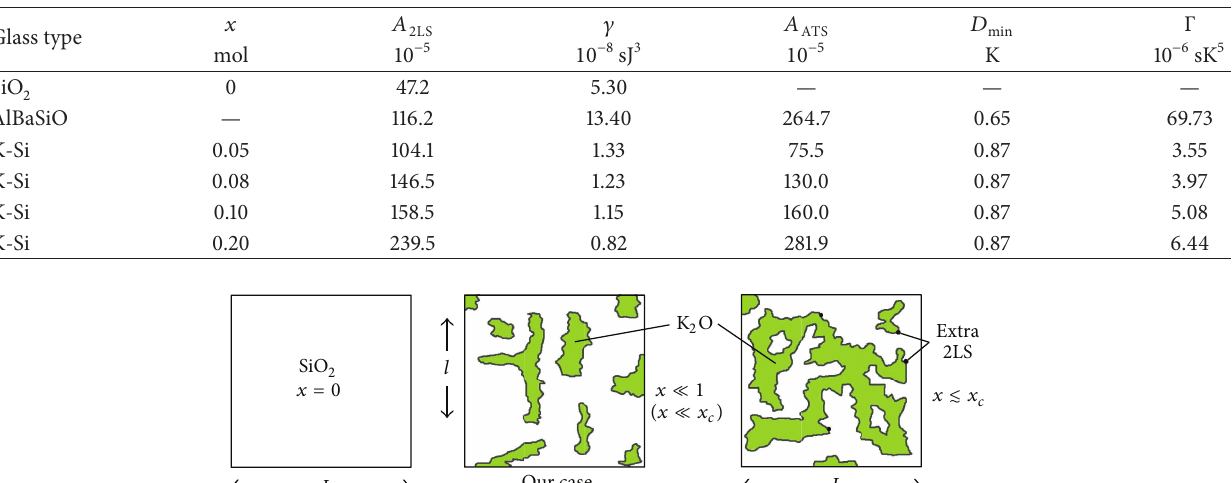
Table 1: Extracted parameters for the glasses; K-Si stands for the ( SiO 2 ) 1−𝑥 ( K Δ